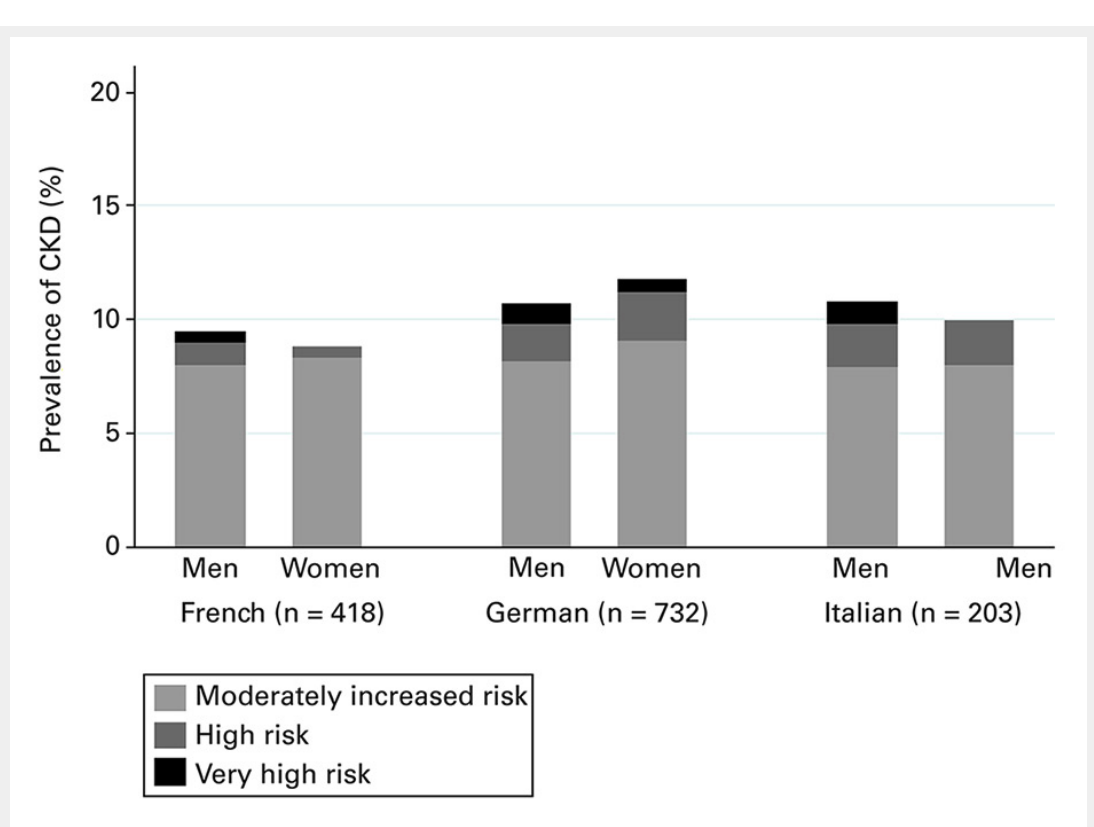
Figure 1 Prevalence of chronic kidney disease (KDIGO 2012), by gender and linguistic region. p-value not significant for difference between genders for each linguistic region (chi squared test); p-value not significant for difference between linguistic regions (chi squared test). KDIGO = Kidney Disease – Improving Global